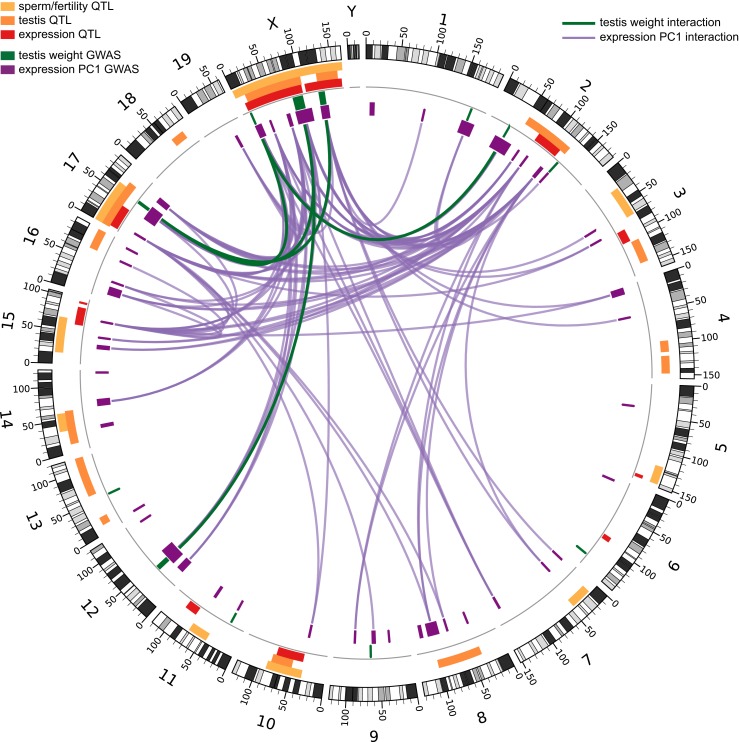
Genetic interactions associated with hybrid sterility in hybrid zone mice and in F2 hybrids.Orange boxes in outer rings indicate QTL for testis-related phenotypes (testis weight and seminiferous tubule area) identified in previous studies, yellow boxes indicate QTL for other sterility phenotypes, and red boxes indicate trans eQTL hotspots (see Table 2 for details). Green boxes indicate significant GWAS regions for relative testis weight. Purple boxes indicate significant GWAS regions for testis expression PC1. Lines represent significant genetic interactions identified in hybrid zone mice for relative testis weight (in green) and expression PC1 (in purple), which are concordant with genetic interactions identified by mapping expression traits in F2 hybrids (Turner et al., 2014). Plot generated using circos (Krzywinski et al., 2009).